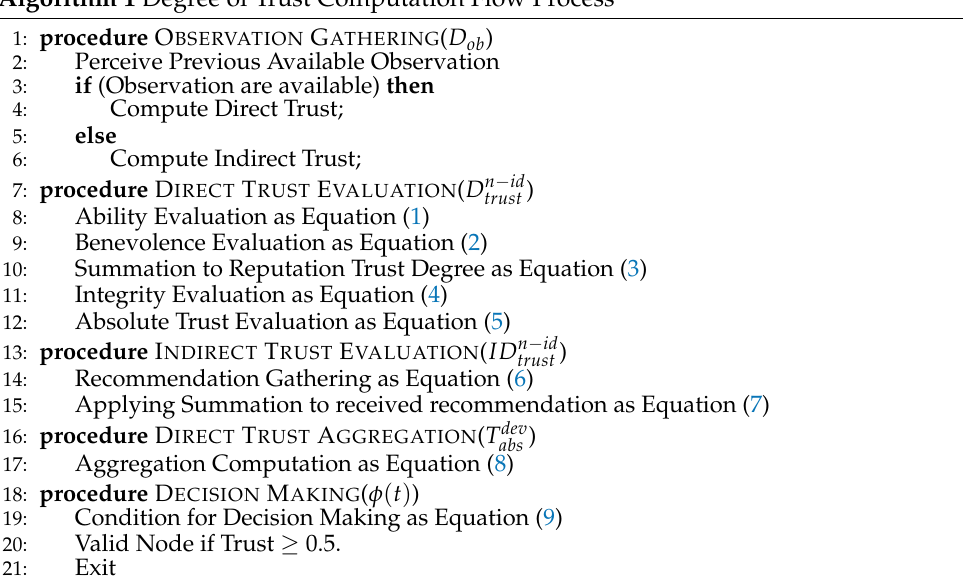
Algorithm 1 Degree of Trust Computation Flow